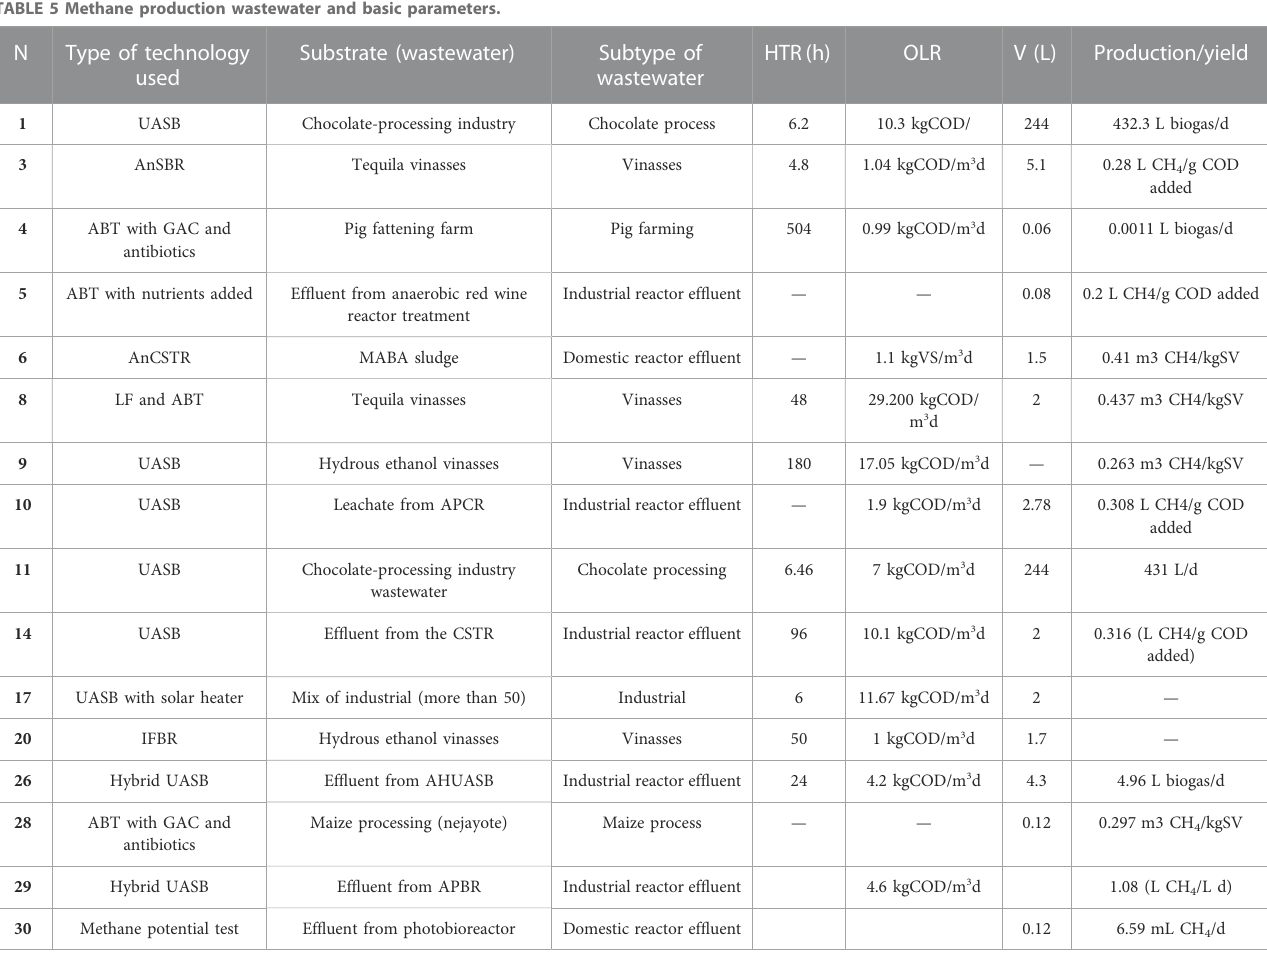
TABLE 5 Methane production wastewater and basic